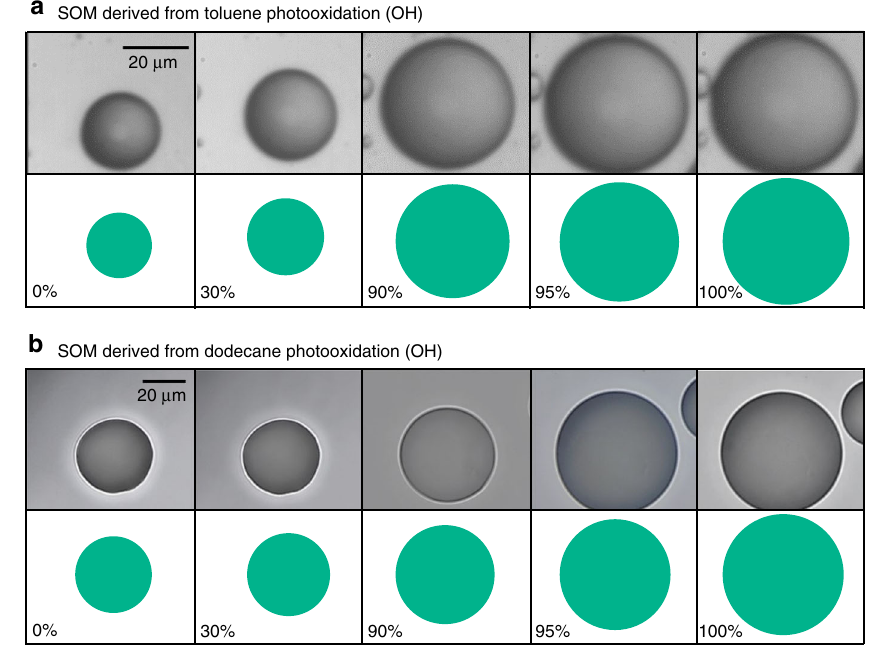
Fig. 5 Optical microscope images show the absence of LLPS for the entire relative humidity range. Illustrations of the images are shown for clarity. SOM particles were derived from a toluene photooxidation and b dodecane photooxidation. Images for toluene-derived SOM were taken from previous experiments